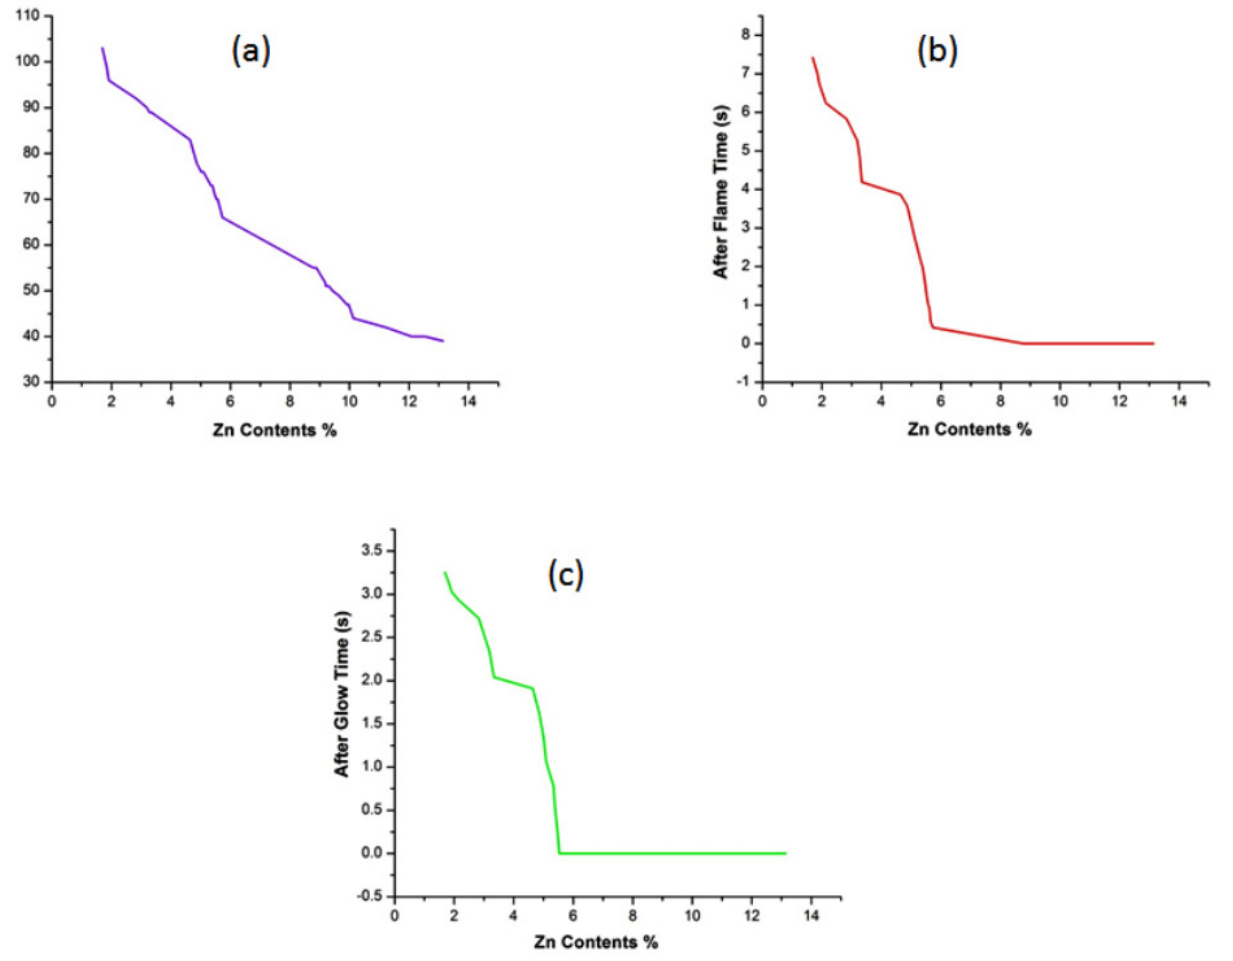
Figure 7. Flammability behavior of ( a ) char length against Zn contents, ( b ) after flame time against Zn contents, and ( c ) after glow time against Zn contents.